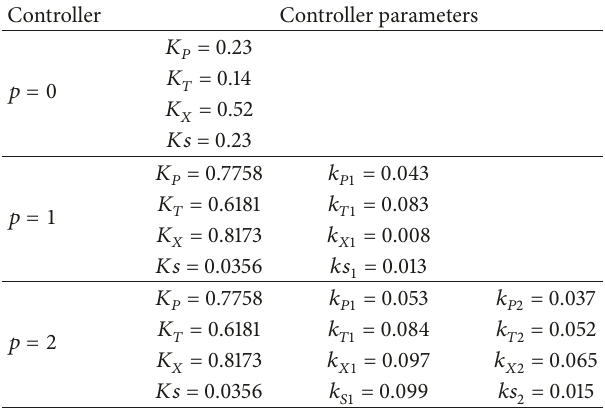
Table 2: Main simulation results in the Monte Carlo experiments. Controller Controller